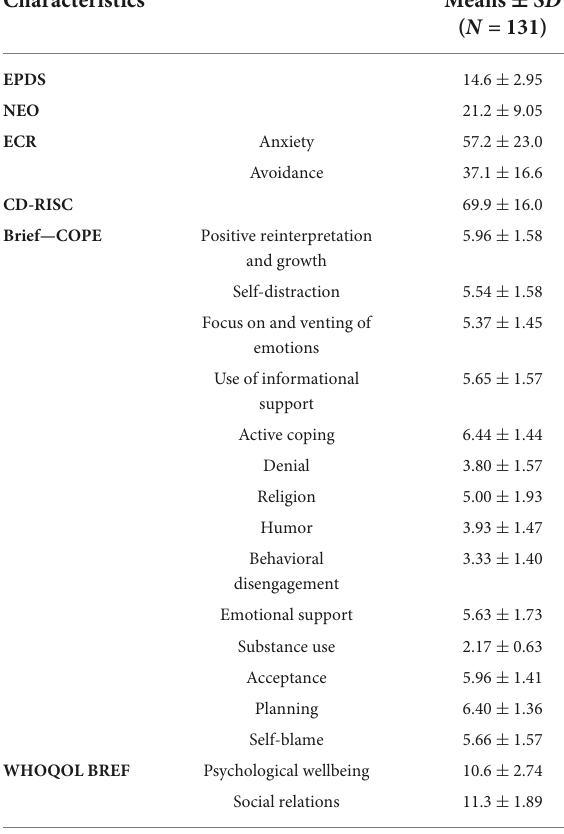
TABLE 5 Psychological assessment at intake for women reporting EPDS total score ≥ 12 (T1; N = 131).